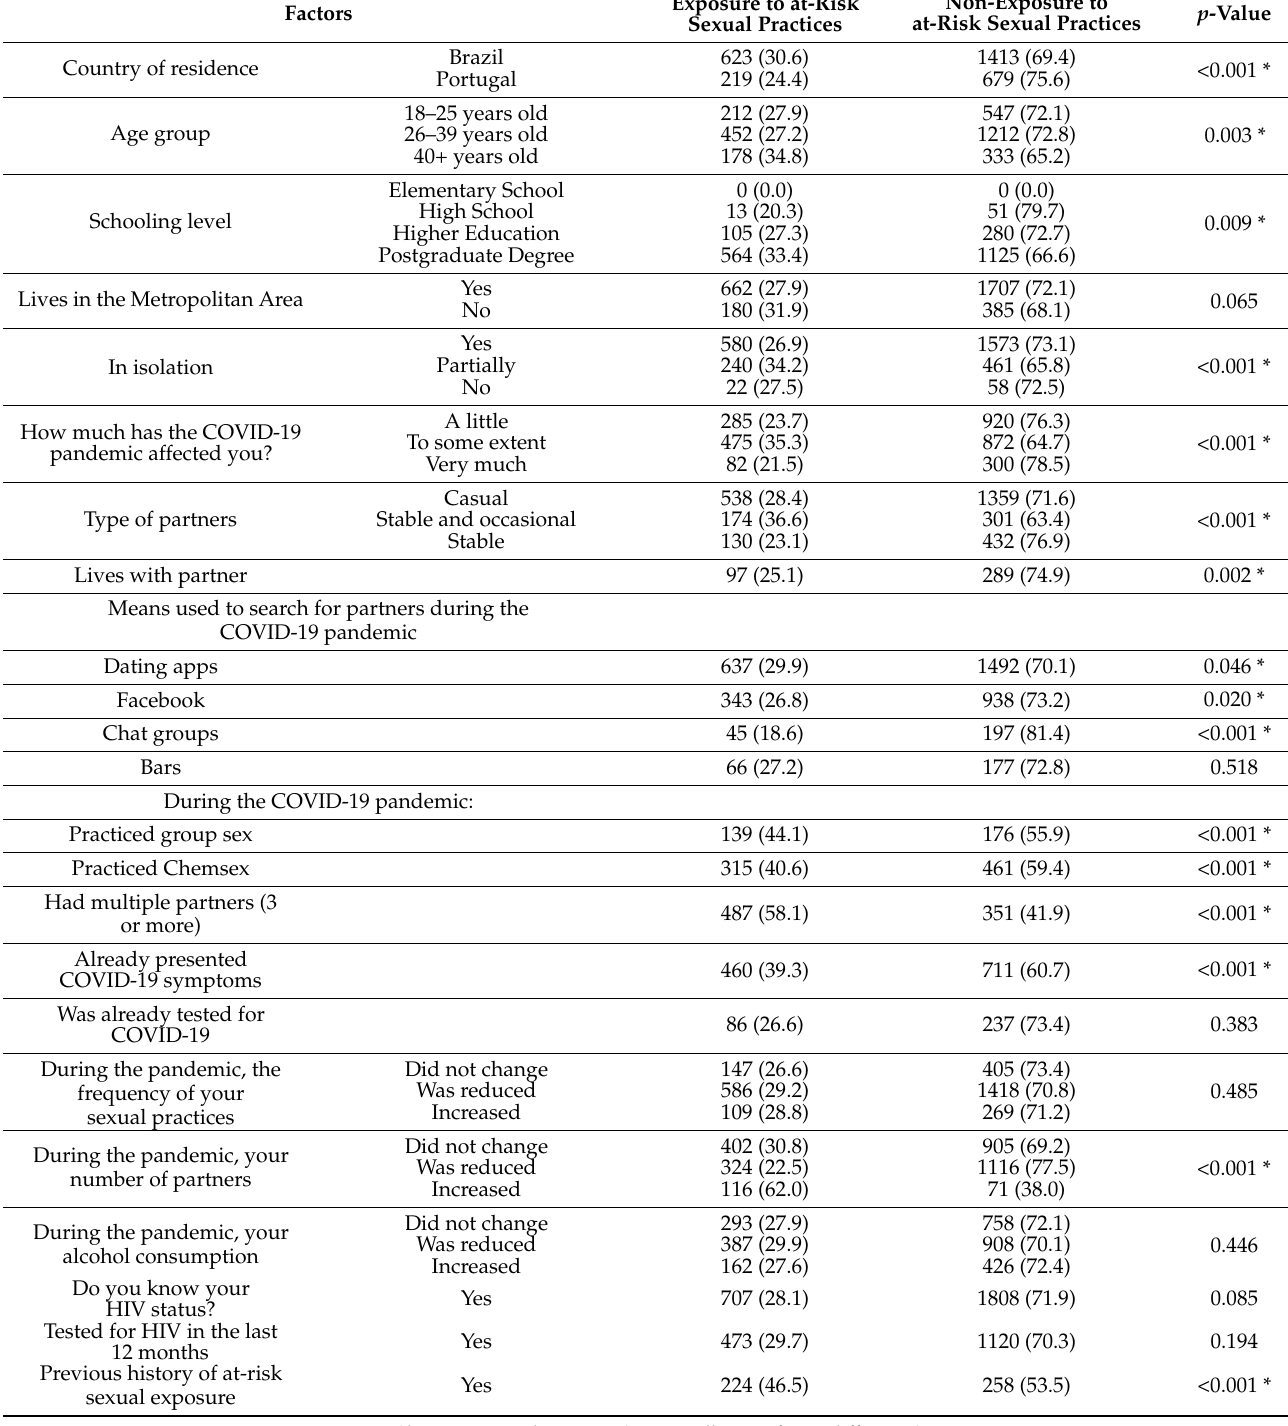
Table 1. Characteristics of Men who Have Sex with Men and their relation with exposure or non-exposure to at-risk sexual practices during the COVID-19 pandemic, Brazil and Portugal, 2020. Exposure to at-Risk Factors Sexual